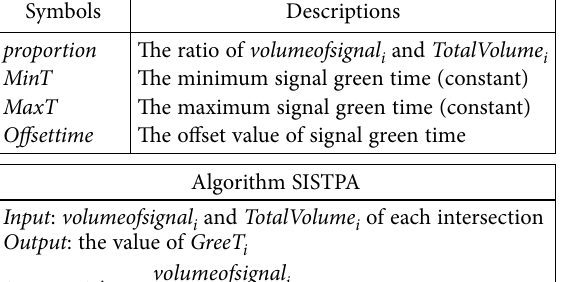
Table 3. Symbol definition of SISTPA Symbols